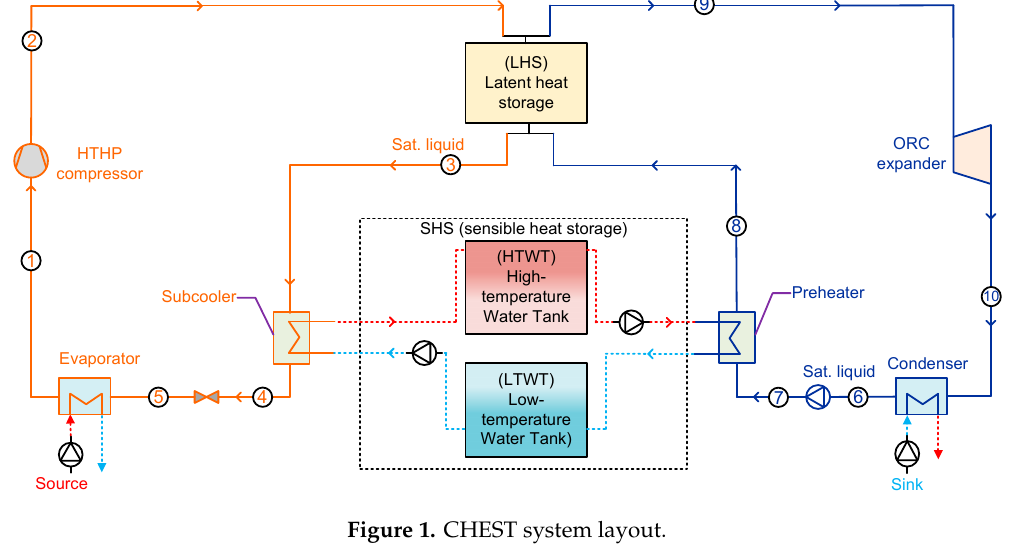
Figure 1. CHEST system layout.